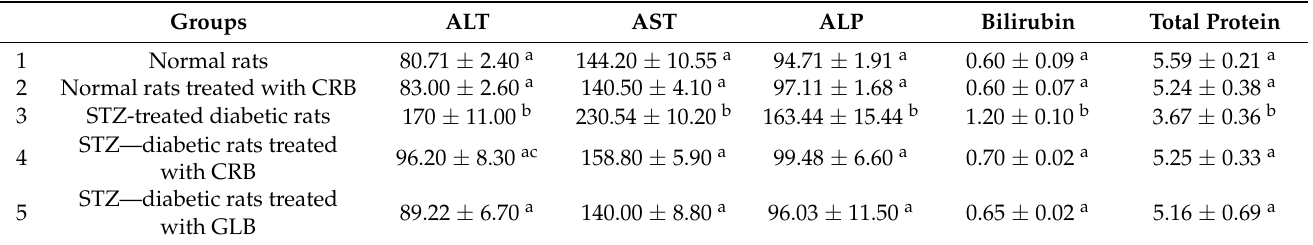
Table 4. Effect of n-butanol fraction of Colvillea racemosa total extract (CRB) orally administered on liver function in Streptozotocin (STZ)-induced diabetic